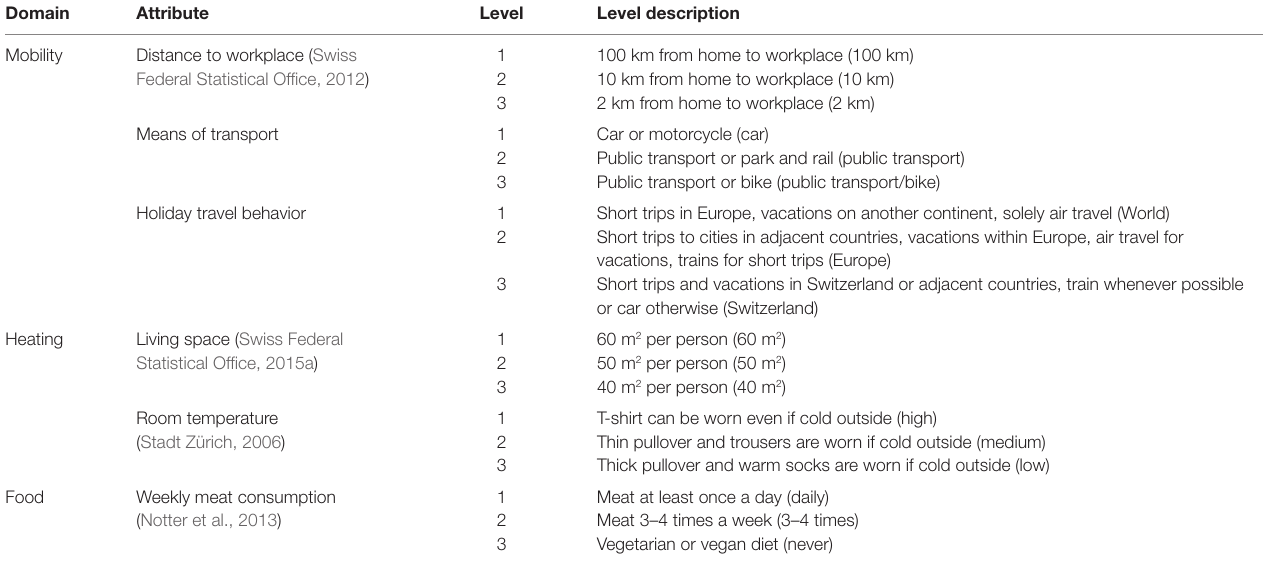
Terms in brackets indicate the short labels for the